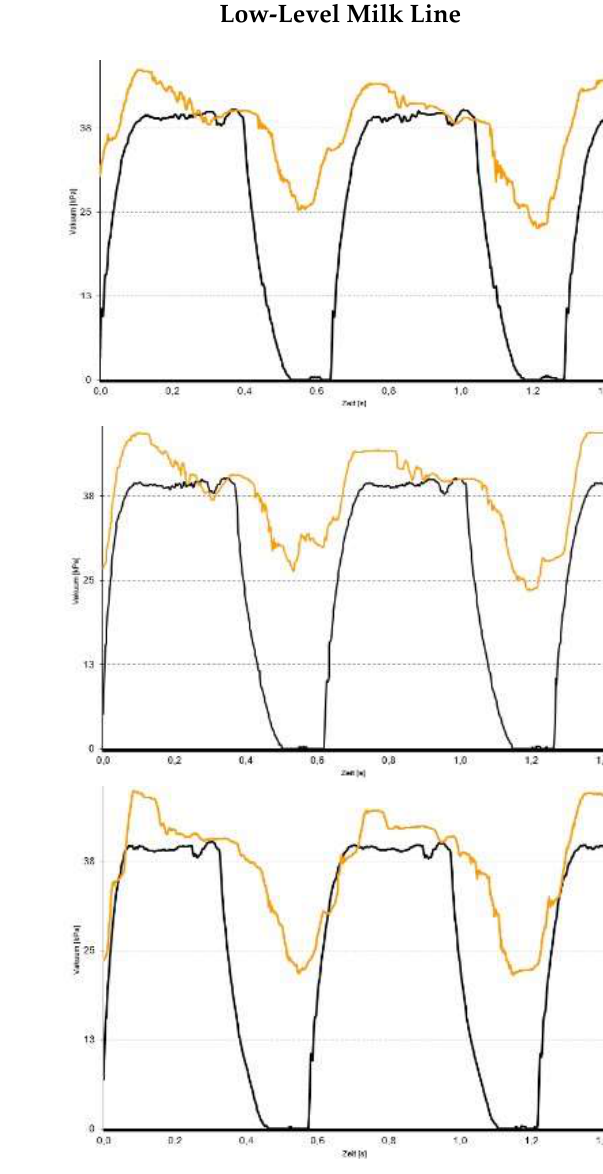
Figure 8. Cyclical vacuum fluctuations in the pulsation and inner chamber of the teat cup during the 1st WF in the goat milking machine, with the following settings: 40 vacuum level (kPa), 90 pulsation rate (cycles/min) and 60:40 pulsation ratio.